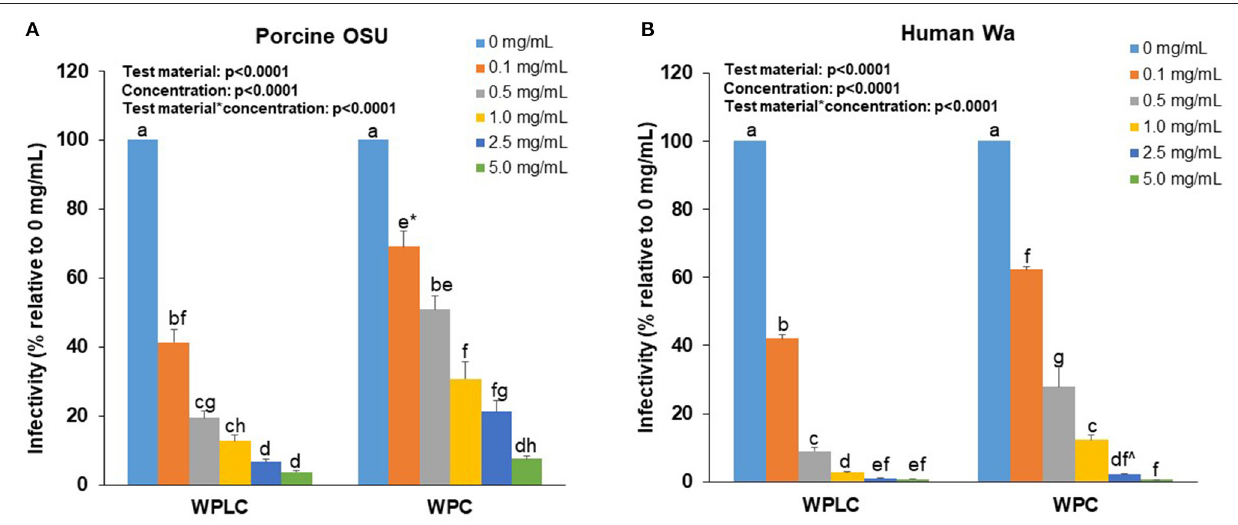
FIGURE 1 | Concentration-dependent reduction of porcine OSU (A) or human Wa (B) RV strains infectivity in MA-104 cells by WPLC and WPC. Data are represented as means ± SEM of three separate experiments. Infectivity was calculated as % of FFU at each concentration relative to FFU counted in cells infected with RV alone (0 mg/mL). Statistical analysis assessed test material, concentration and test material * concentration effects. Unlike letters represent significant differences ( p < 0.05) between concentrations within a test material and between WPLC and WPC. * Difference between WPC 0.1 and 0.5 mg/mL is at trend level ( p = 0.058). ∧ Difference between WPC 2.5 and 5.0 mg/mL is at trend level ( p = 0.067). RV, rotavirus; WPC, whey protein concentrate; WPLC, whey protein lipid